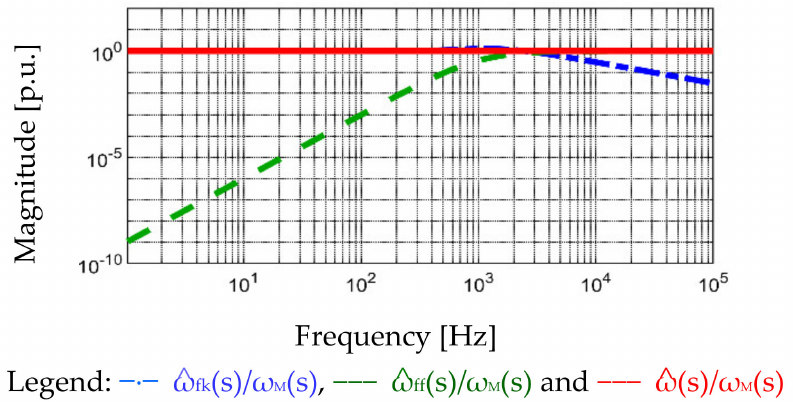
Figure 9. Frequency responses of different speed estimations at different frequencies (ideal parameter estimation, ˆK t = K t and ˆJ ALL = J ALL ).